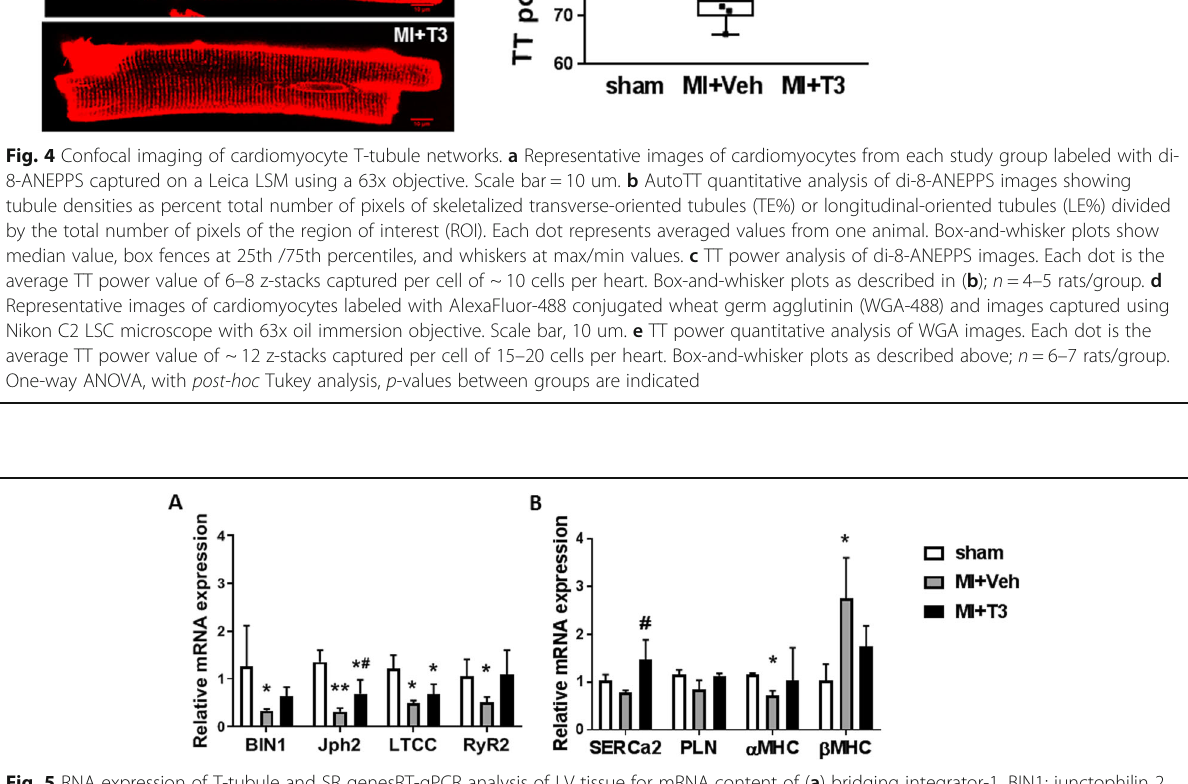
Fig. 5 RNA expression of T-tubule and SR genesRT-qPCR analysis of LV tissue for mRNA content of ( a ) bridging integrator-1, BIN1; junctophilin 2, Jph2; L-type calcium channel, LTCC; ryanodine 2, RyR2 and ( b ) SR calcium ATPase, SERCa2; phospholamban, PLN; alpha- and beta-myosin heavy chain, α MHC and β MHC. The binary log of ΔΔ Ct calculations of PCR cycle amplifications was used to determine the fold-change relative to the mean values of the Sham group. Bar graph shows mean ± SD for n = 4 – 6 hearts/group. Statistical analysis used one-way ANOVA with post-hoc Tukey ’ s multi-group comparisons: * p < 0.05 vs sham; ** p < 0.001 vs sham; # p < 0.01 vs MI +